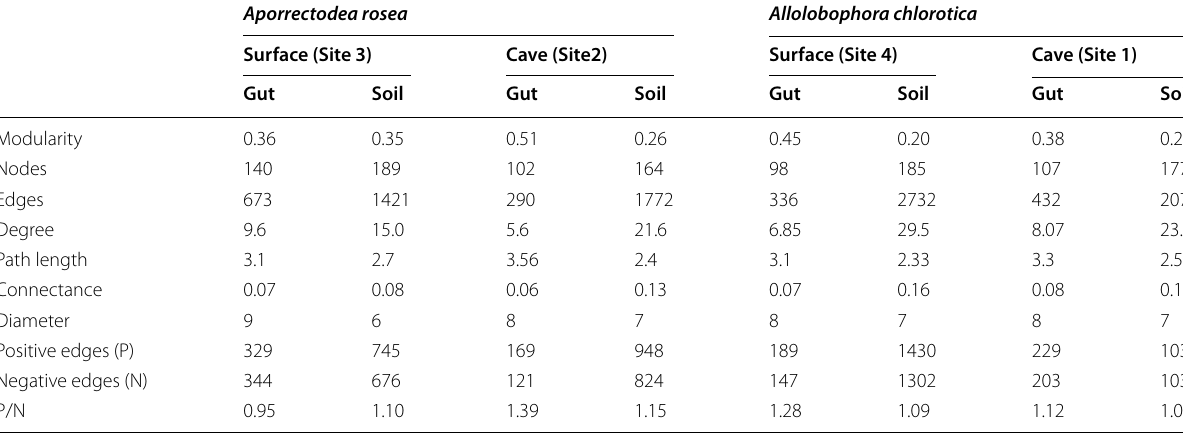
Table 2 Network topologies of the gut and soil microbiota Aporrectodea rosea Allolobophora